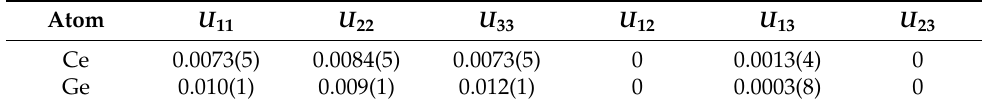
Table 5. Components of the anisotropic displacement tensor U for